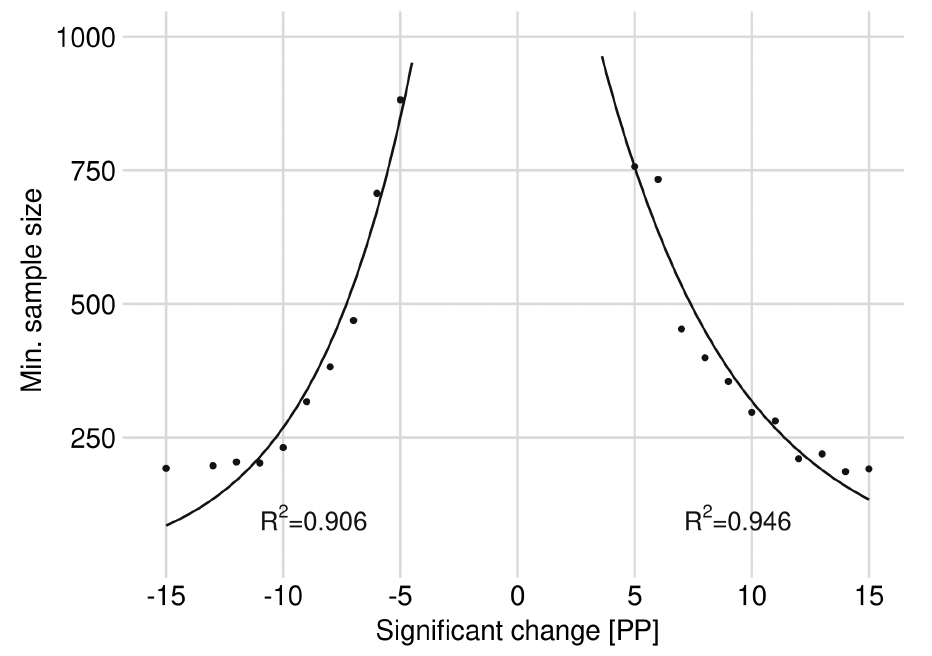
Figure 3. Minimum required sample sizes to achieve a significant BP change based on the data from 2015 to 2018 for rowan; fitted by exponential functions with coefficient of determination (R 2